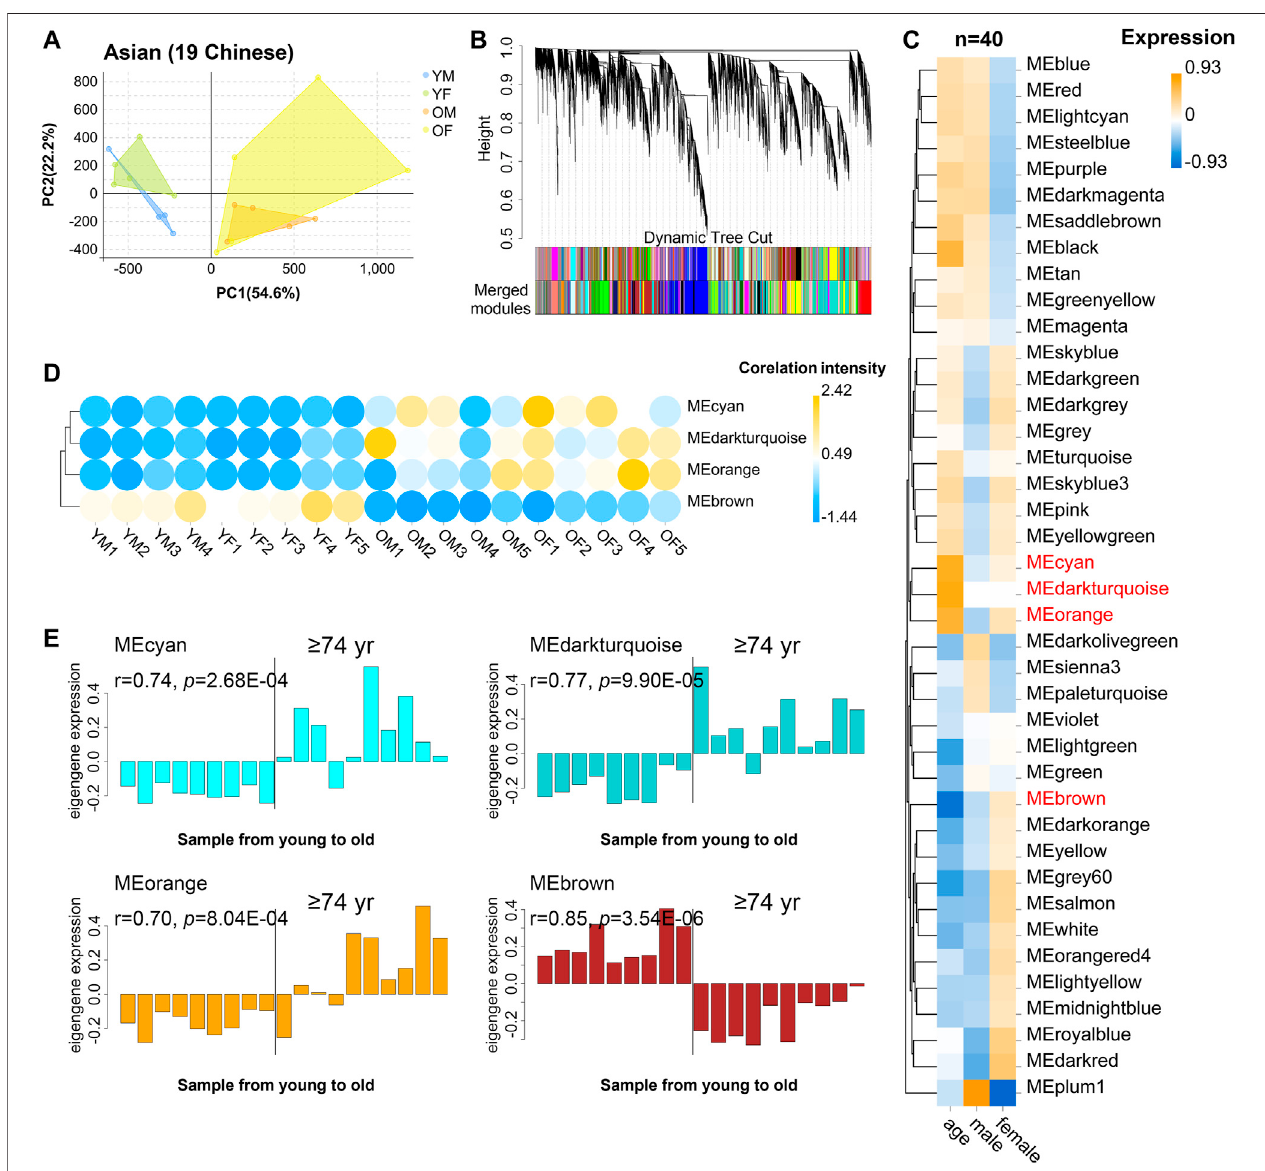
FIGURE 3 | The characteristic gene expression of PBMC aging in Asian (Chinese). Transcriptome data of 19 healthy human subjects in Guangdong China were analyzed, and gene modules were constructed by WGCNA. (A) Principal component analyses. Young and old individuals were largely separated according to the principal component1 scores (PC1). (B) Cluster dendrogram. Each branch represents one gene, and each color below denotes one co-expression gene module. The two colored rows below the dendrogram represented the original and merged modules, respectively. (C) Heatmap of the Pearson ’ s correlation between trait (age and gender) and module eigengene (ME, n (cid:1) 40). The column and row corresponded to trait and ME, respectively. The color in each cell represented corresponding correlation and scaled in the colorlegend. (D) Hierarchical cluster analyses of four interested modules. Based on themodule-trait ’ sPearson ’ s r and p value (absolute r > 0.5, p < 0.05), three modules (cyan, darkturquoise, and orange) showed relatively lower expression in young PBMC groups and high expression in the aged, while the brown modules showed the opposite result. Each dot represented an individual. (E) The histograms of the eigengene expression in the four age-related modules from young to